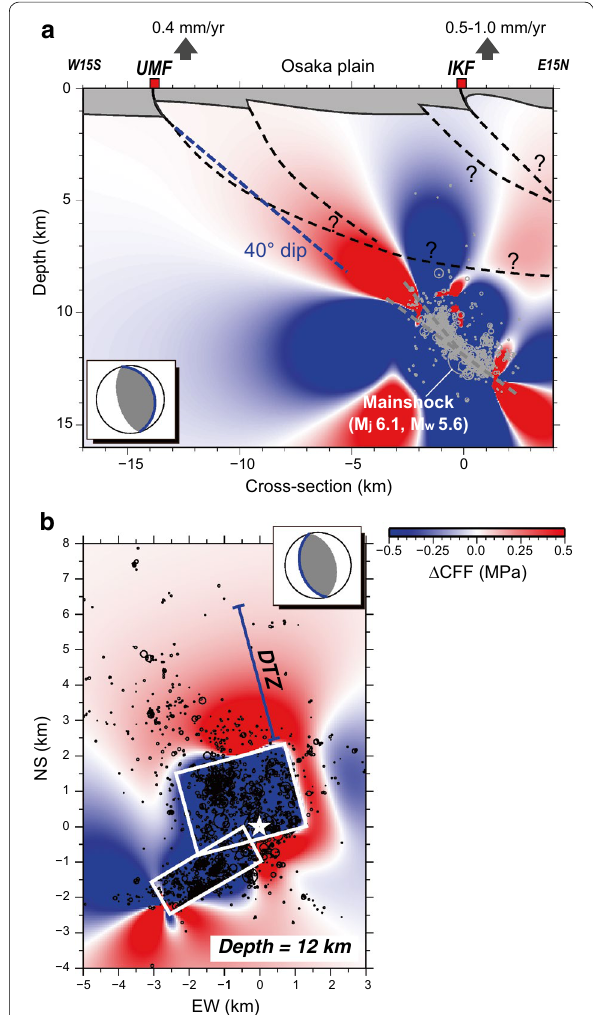
Fig. 5 a Seismic diagram showing the fault systems beneath the Osaka Plain along an ENE–WSW profile, superimposed on the Coulomb stress changes resolved on east-dipping thrust fault (strike 345°, dip 30°, rake 90°) induced by the mainshock = = = rupture. The receiver fault is shown as a blue curve in the inset. The black dashed curves denote the deep fault geometries interpreted by Sato et al. (2009). The blue dashed line shows a simple 40°-dipping extension of the UMF near-surface geometry. The gray circles are the relocated hypocenters along cross sections 01–03 in Fig. 2b. The solid arrows denote the reported vertical slip rates of the active faults in mm/year. b Calculated Coulomb stress changes at 12 km depth resolved on west-dipping thrust fault (strike 165°, dip 45°, = = rake 90°) induced by the mainshock rupture. The receiver fault = is shown as a blue curve in the inset. DTZ indicates the zone with delayed triggered aftershocks. The white star denotes the mainshock epicenter, and the white rectangles are the two source fault models inferred from the present